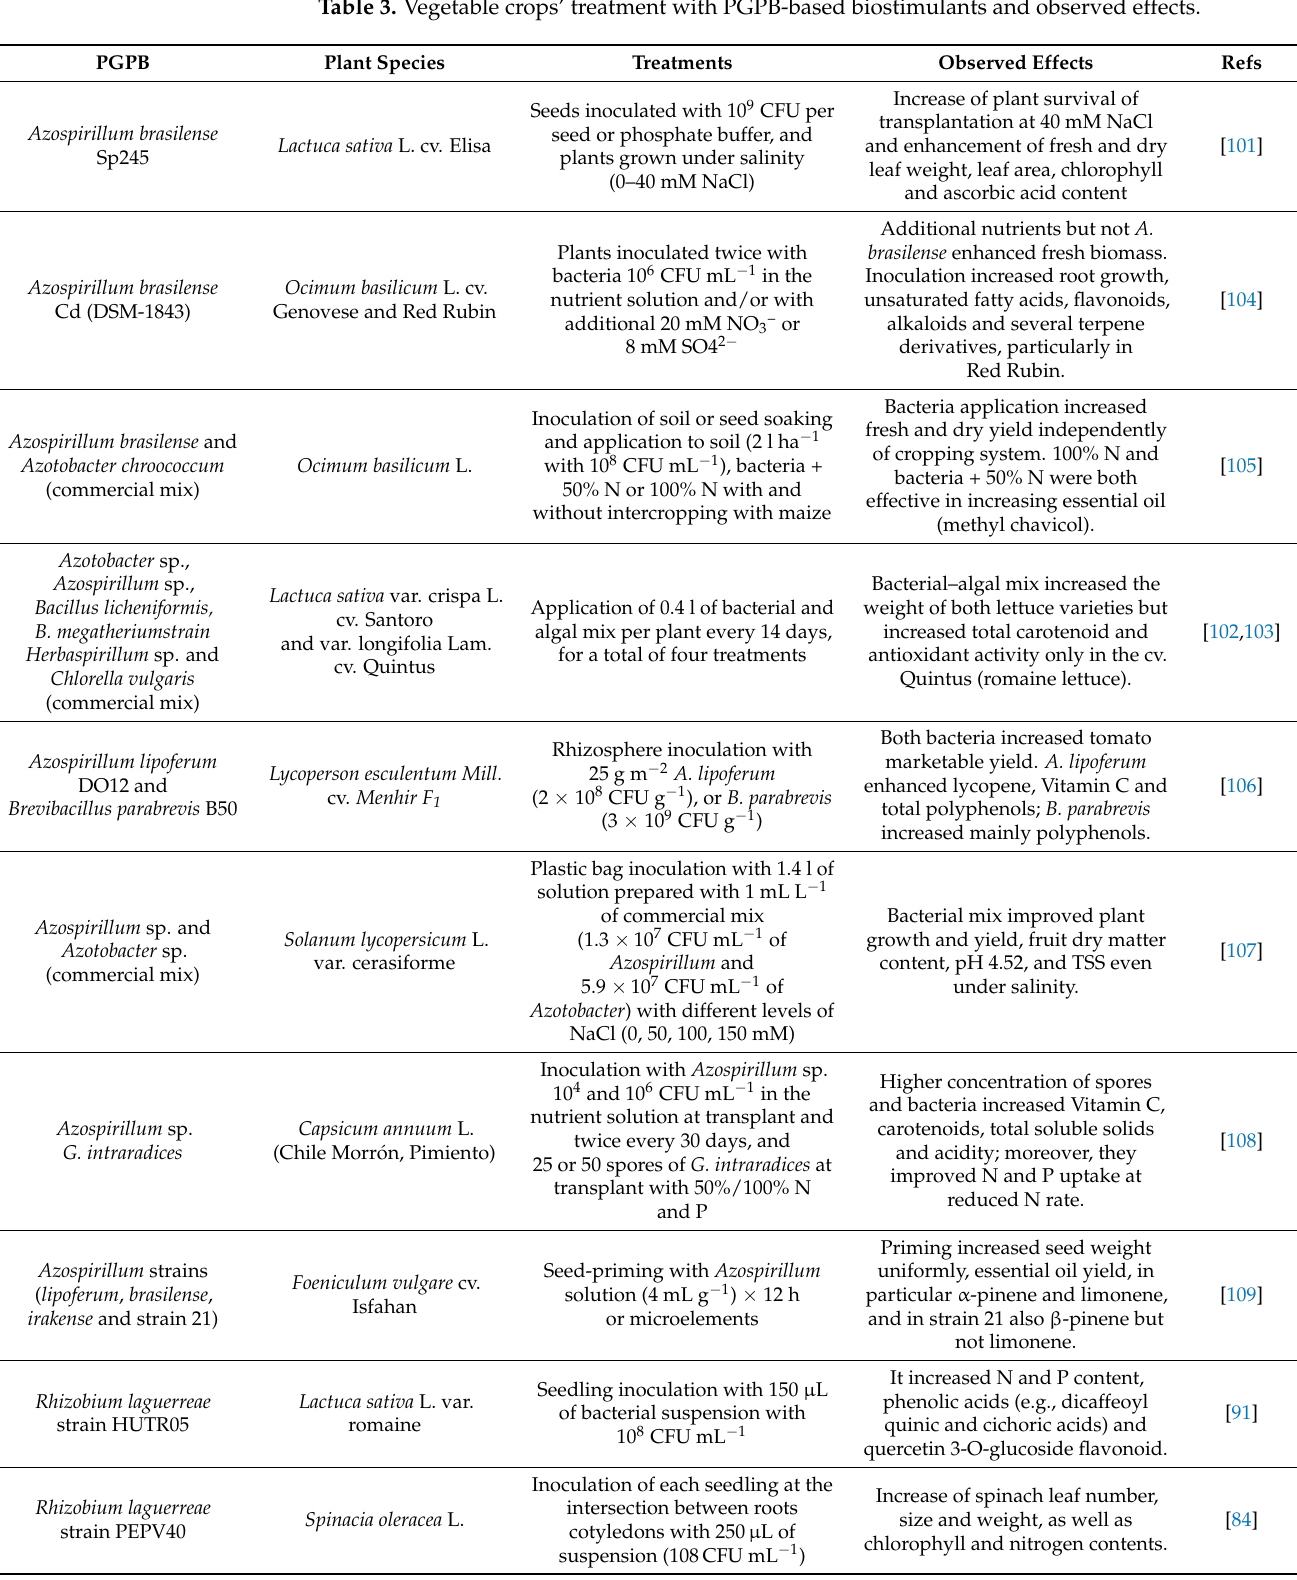
Table 3. Vegetable crops’ treatment with PGPB-based biostimulants and observed